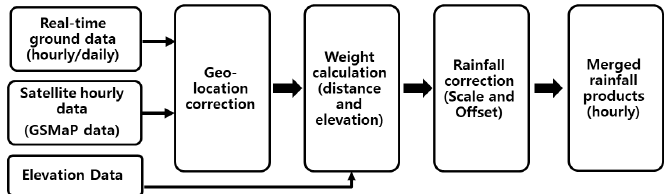
Figure 3. Flow chart for the NTT-DATA GSMaP bias-correction algorithm.